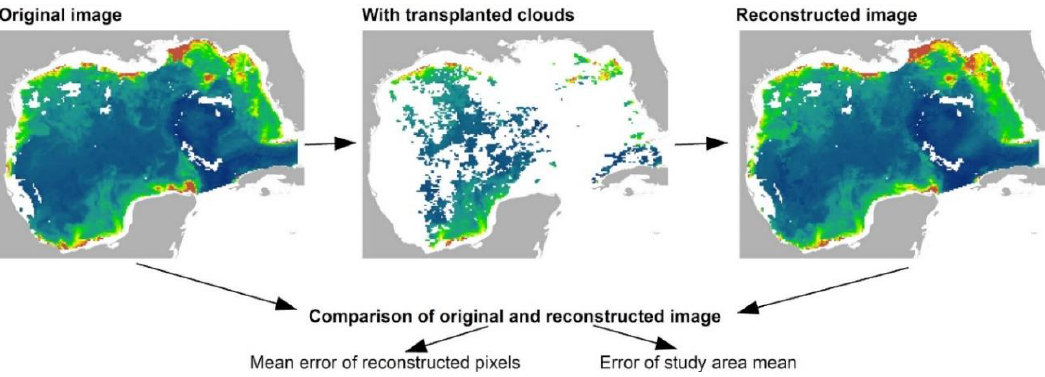
Figure 3. We estimated the accuracy of each gap-filling algorithm (shown here: spatiotemporal Kriging) by adding clouds from cloudy images onto relatively cloud-free images, then using the algorithm to reconstruct the original image and calculate two error measures: the root mean squared error (RMSE) of the reconstructed pixels and the difference between the original and reconstructed image’s mean Chl a concentrations. We repeated this process for hundreds of combinations of original images and cloud masks in four study areas and thus were able to calculate the algorithms’ mean errors over many realistic situations.